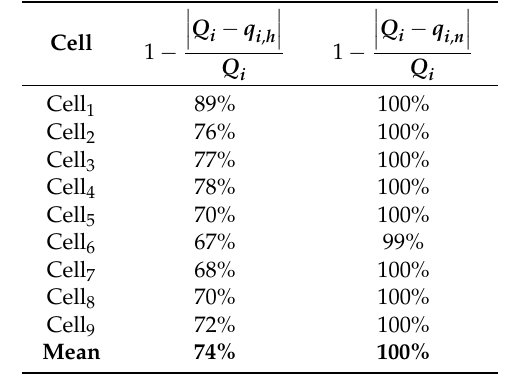
Table 3. The accuracies of traffic flow estimation of each road